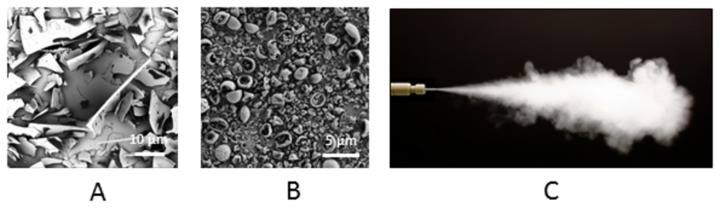
Images of oxytocin particles.Scanning electron micrographs of unprocessed oxytocin and oxytocin loaded carrier particles; (A) unprocessed commercial oxytocin (x 375); (B) oxytocin formulated as an ultrafine dry powder with the glycine-leucine-mannitol carrier (x 5000). (C) Well-dispersed aerosolised plume of ultrafine particles emitted from an insufflator.